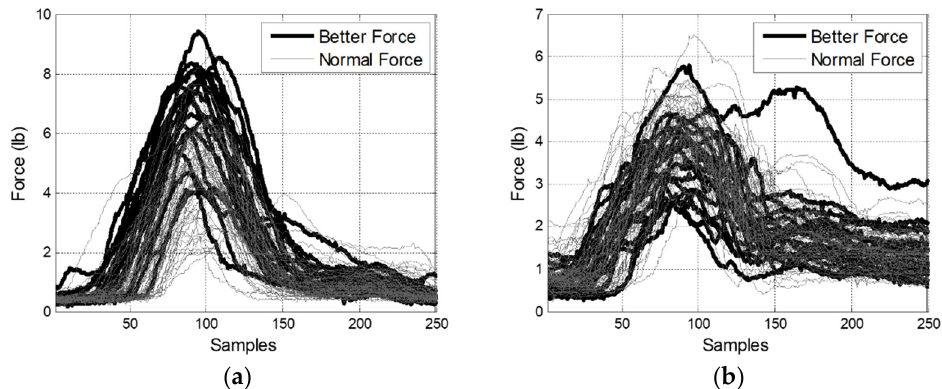
Figure A2. The intervention forces. ( a ) on the left pelvic; ( b ) on the right